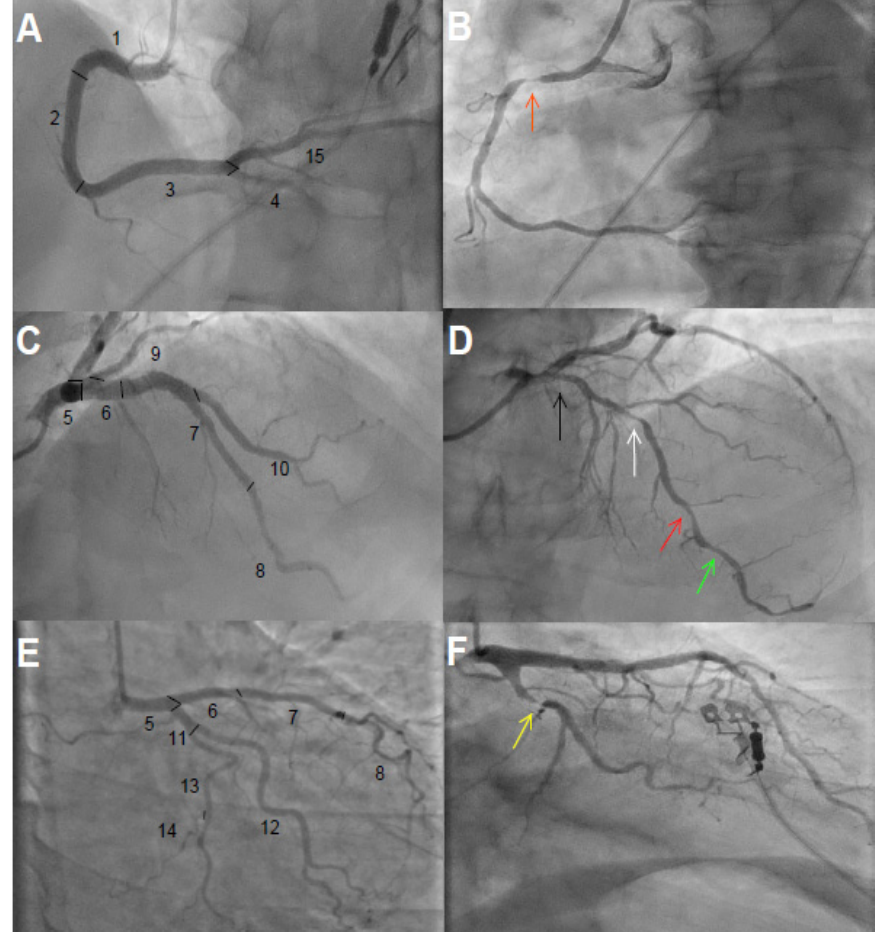
Figure 2. Coronary angiograms. ( A , C , E ) show 15 segments of the coronary tree classified according to the American Heart Association without significant obstructive coronary artery disease. ( A ): 1 = Proximal right coronary artery, 2 = middle right coronary artery, 3 = distal right coronary artery, 4 = right posterior descending artery, and 15 = left posterior descending artery; ( C ): 5 = left main coronary artery, 6 = proximal left anterior descending artery, 7 = middle left anterior descending artery, 8 = distal left anterior descending artery, 9–10 = first and diagonal branches of left anterior descending artery; ( E ): 11 = proximal left circumflex, 12 = obtuse marginal branch, 13 = distal left circumflex, 14 = posterolateral branch. ( B ): significant obstructive coronary artery disease with stenosis ~90% (orange arrow) in segment 1; the longitudinal extent of atherosclerosis was ~70%. ( D ): Arrows from right to left show ~40% (black), ~60% (white), ~60% (red), and ~40% (green) stenosis in segments 6, 7, 8, and 8, respectively. Longitudinal extent of atherosclerosis was ~80% in segment 6, ~90% in segment 7, and ~80% in segment 8. ( F ): ~90% stenosis in segment 11 (yellow arrow) with estimated ~50% longitudinal atherosclerosis. The Sullivan extent score (SES) was used to classify the longitudinal extent of CAD [16]. Coronary artery disease was defined as irregularity of any vessel wall obstructing >20% of the total lumen and was estimated relative to the total length of the studied segment. An occluded lesion in any segment was defined as at least 50% longitudinal extent. The proportion of the longitudinal extent of each segment occupied by the lesion was multiplied by a factor representing the surface area of the studied segment relative to the entire coronary tree. The left main coronary artery accounted for 5%, the left anterior descending artery 35%, the left circumflex artery 30%, and right